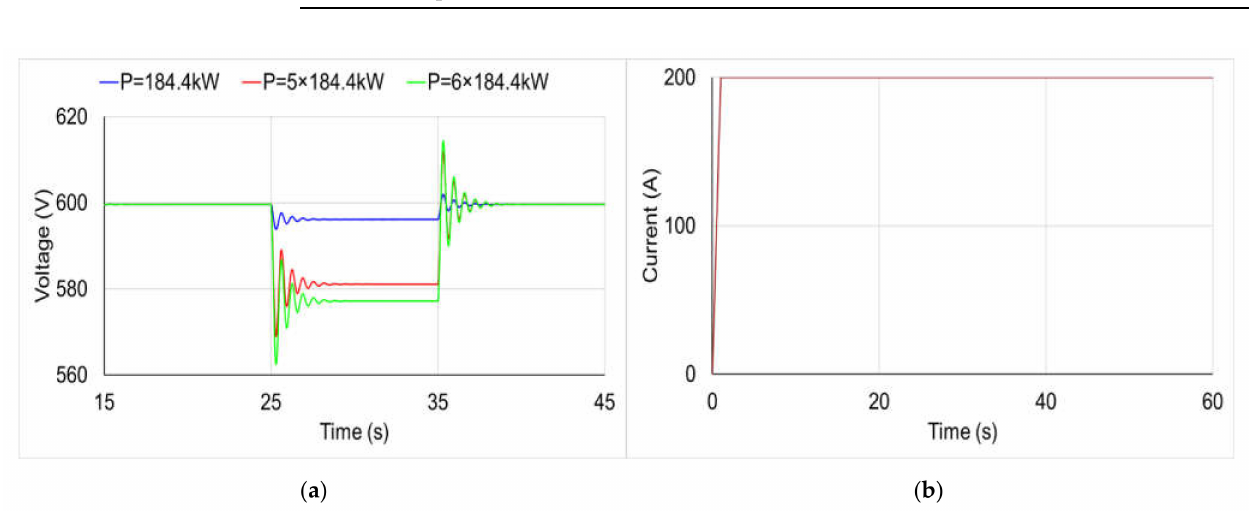
Figure 15. ( a ) DC Voltage ( b ) Current